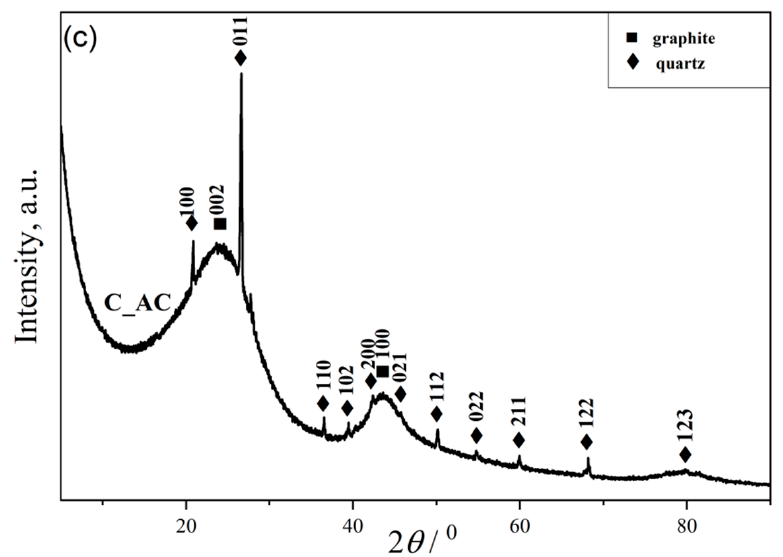
Figure 2. XRD spectra of the: ( a ) raw (P_RS), carbonized (P_CC), and activated (P_AC) dried palm leaf stalk sample; ( b ) raw (A_RS), carbonized (A_CC) and activated (A_AC) black alder cone-like flowers; ( c ) commercial activated carbon (C_AC).